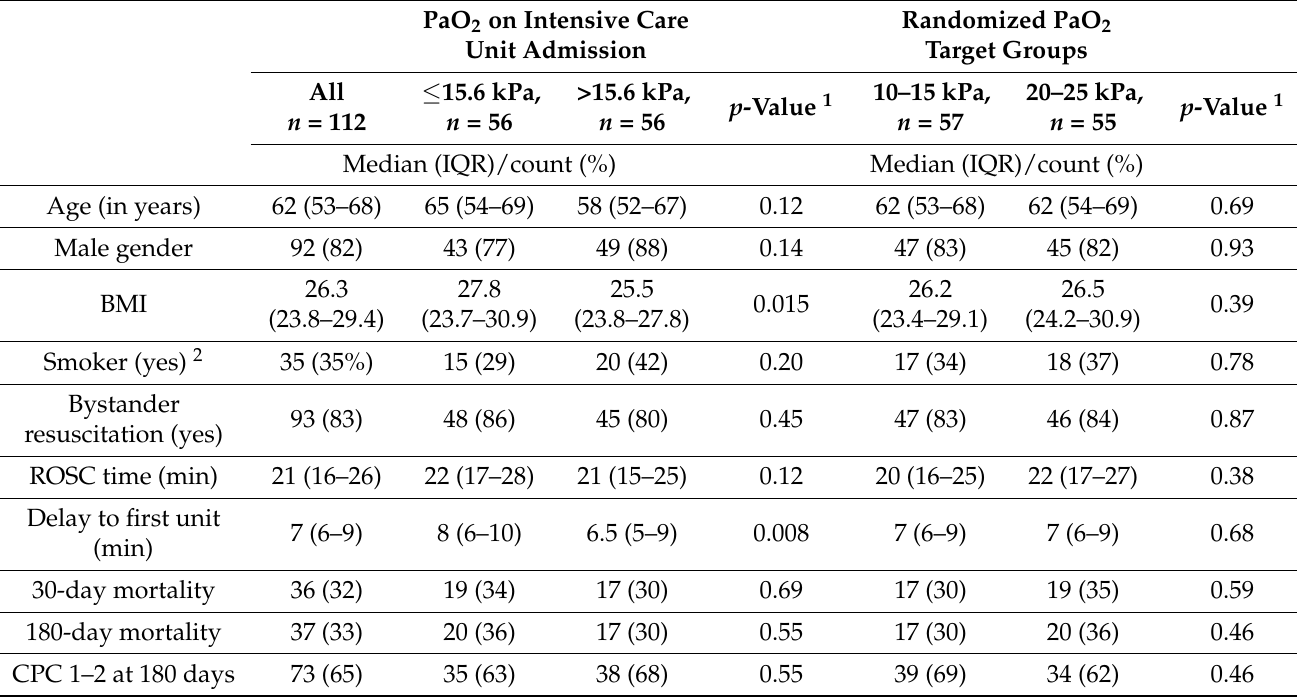
Table 1. Baseline characteristics of complete study population, study population divided by lower vs. higher admission PaO 2 , and study population in randomized oxygen